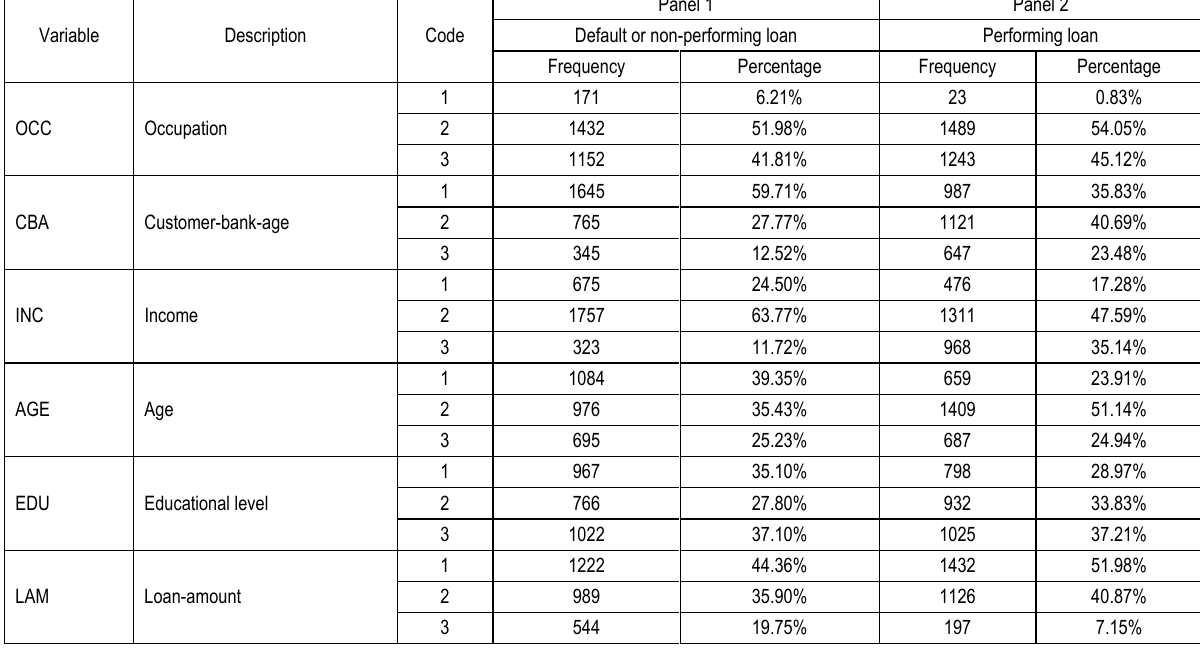
Table 3. Descriptive statistics of the credit risk